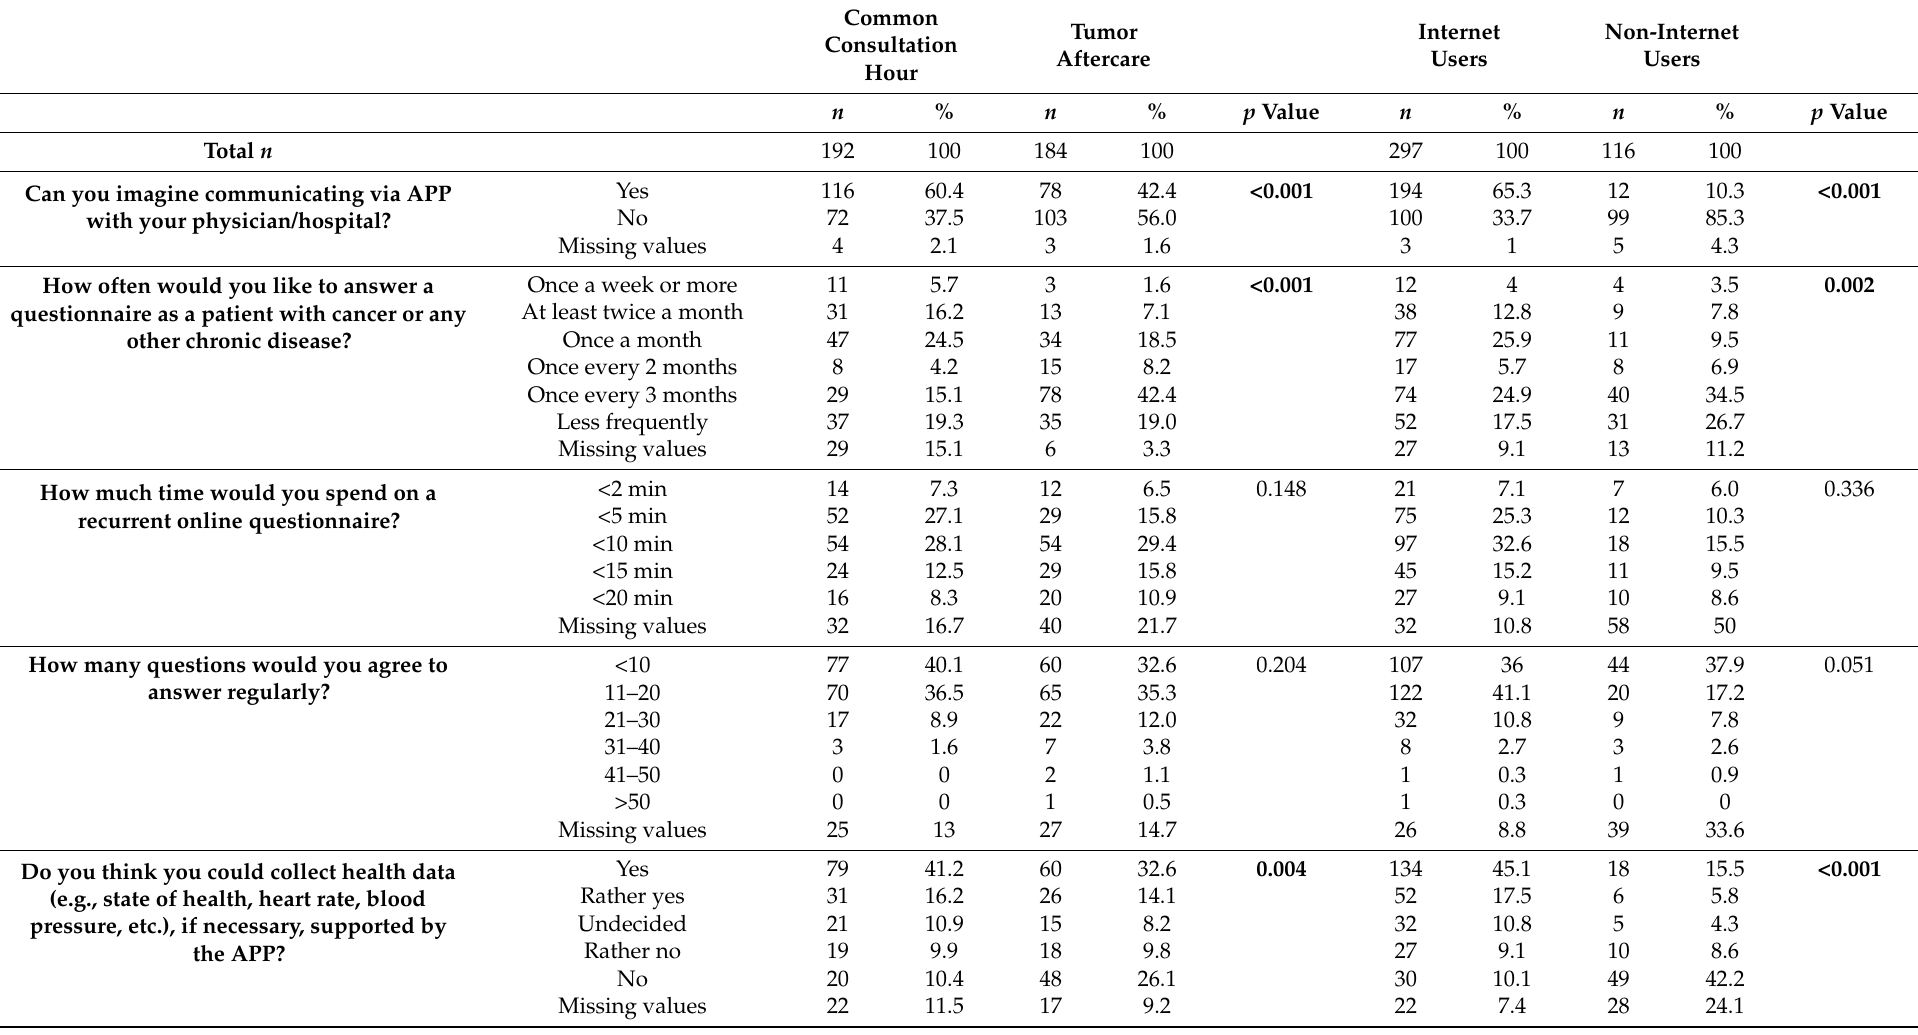
Table 3. Opinion on and attributed chances linked to using digital media in health care for patient-reported outcomes (PRO) and designing ePROM (electronic PRO-measurement) of ENT patients stratified according to reason for consultation (common consultation hour vs. tumor aftercare) and internet use (yes vs.